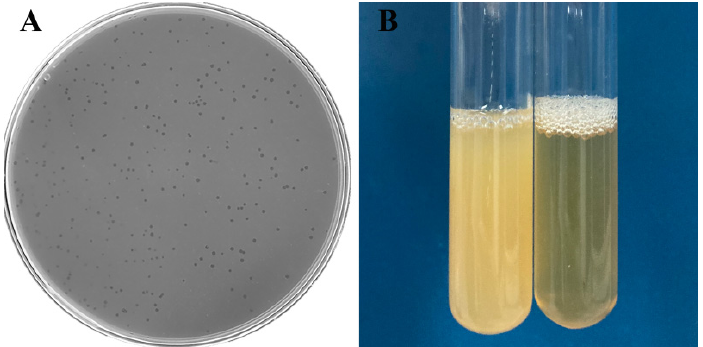
Figure 1. Visualization of Ahy-yong1 plaques and Aeromonas hydrophila A18 cultures. ( A ) Aeromonas phage Ahy-yong1 formed clear and circular plaques on A. hydrophila A18 lawns. Small plaques can be seen in 3 h, and the average diameter of the plaques reached 0.84 mm in 4 h. ( B ) Normal A. hydrophila A18 culture (left) and lysateofphageAhy-yong1-infected A. hydrophila A18 (right).